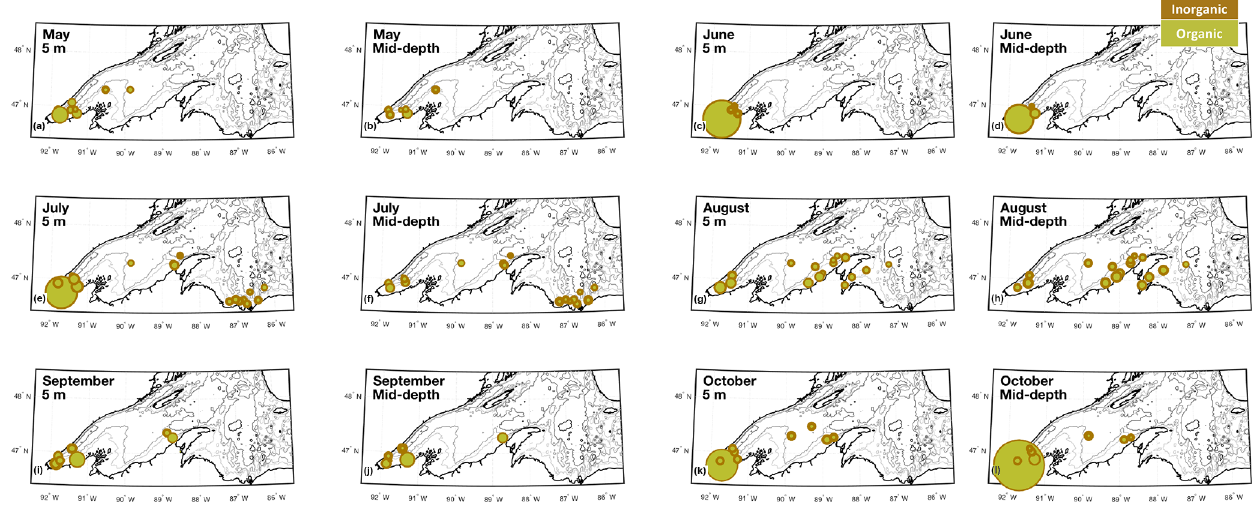
Figure 6. Suspended particulate matter for discrete water samples taken at 5m and mid-depth for the Lake Superior dataset grouped by month. The outer diameter of each station marker indicates total SPM with the concentric circles representing the relative contributions of organic and inorganic